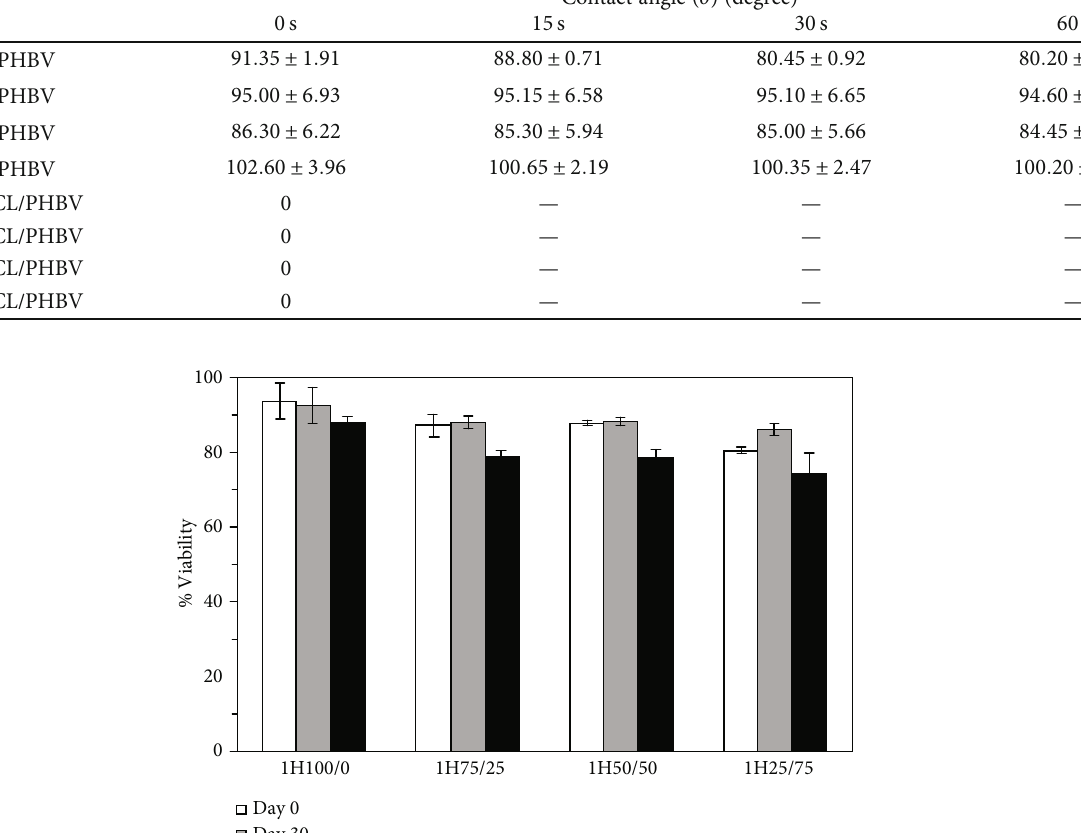
Table 3: Water contact angles as function of time of PCL/PHBV sca ff olds before and after surface modi fi cations with NaOH. Sample